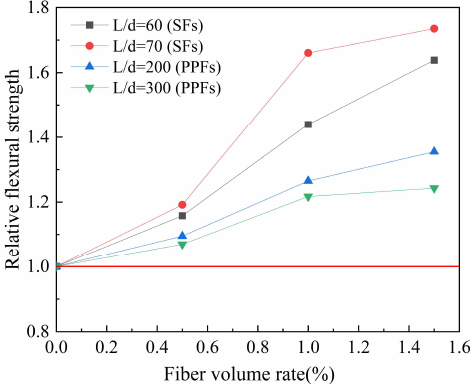
Figure 24. The effect of fiber aspect ratio on flexural strength.